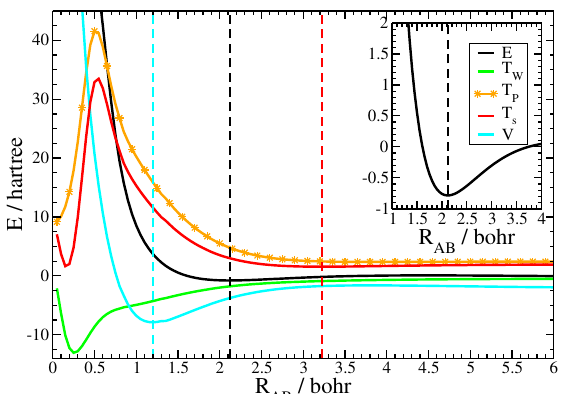
Figure 2. Energetic binding curve for N 2 together with its kinetic and potential components. All data are evaluated as the difference between the molecular data and the groundstate atoms. Black: binding energy E , red: total kinetic energy T s , orange: Pauli kinetic energy T P , green: von Weizsäcker kinetic energy T W , blue: total potential energy V . The dashed lines mark the minima of the respective curves. Inset: binding energy E around the equilibrium